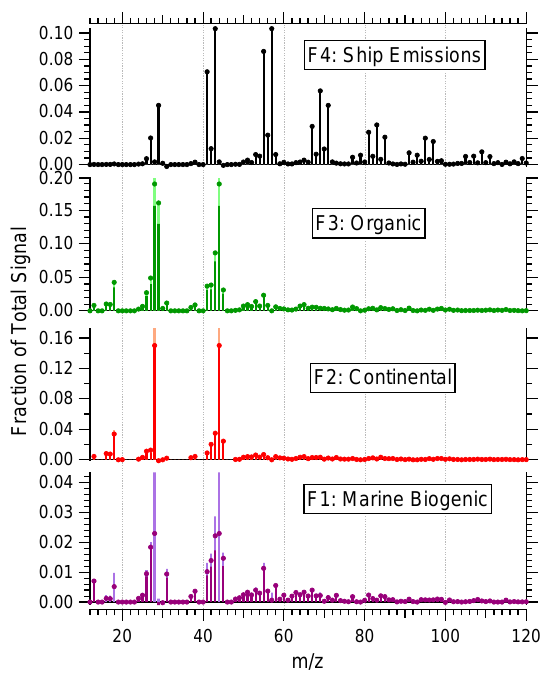
Fig. 8. Mass spectra of the organic components of the PMF factors. The circle represents the solution for an fPeak of − 0 . 75, and the light and solid bars the range for fPeak s of − 1 . 5 and 0. The signal is adjusted so that the sum of the entire signal for each mass spectrum, not only the organics, is one.